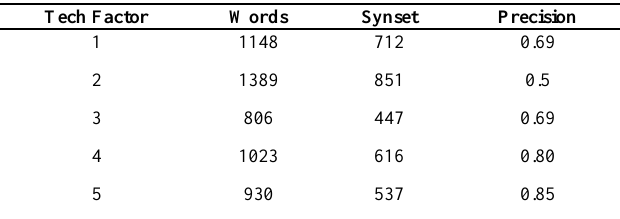
Table 5. Results for semantic relation / TechTerms